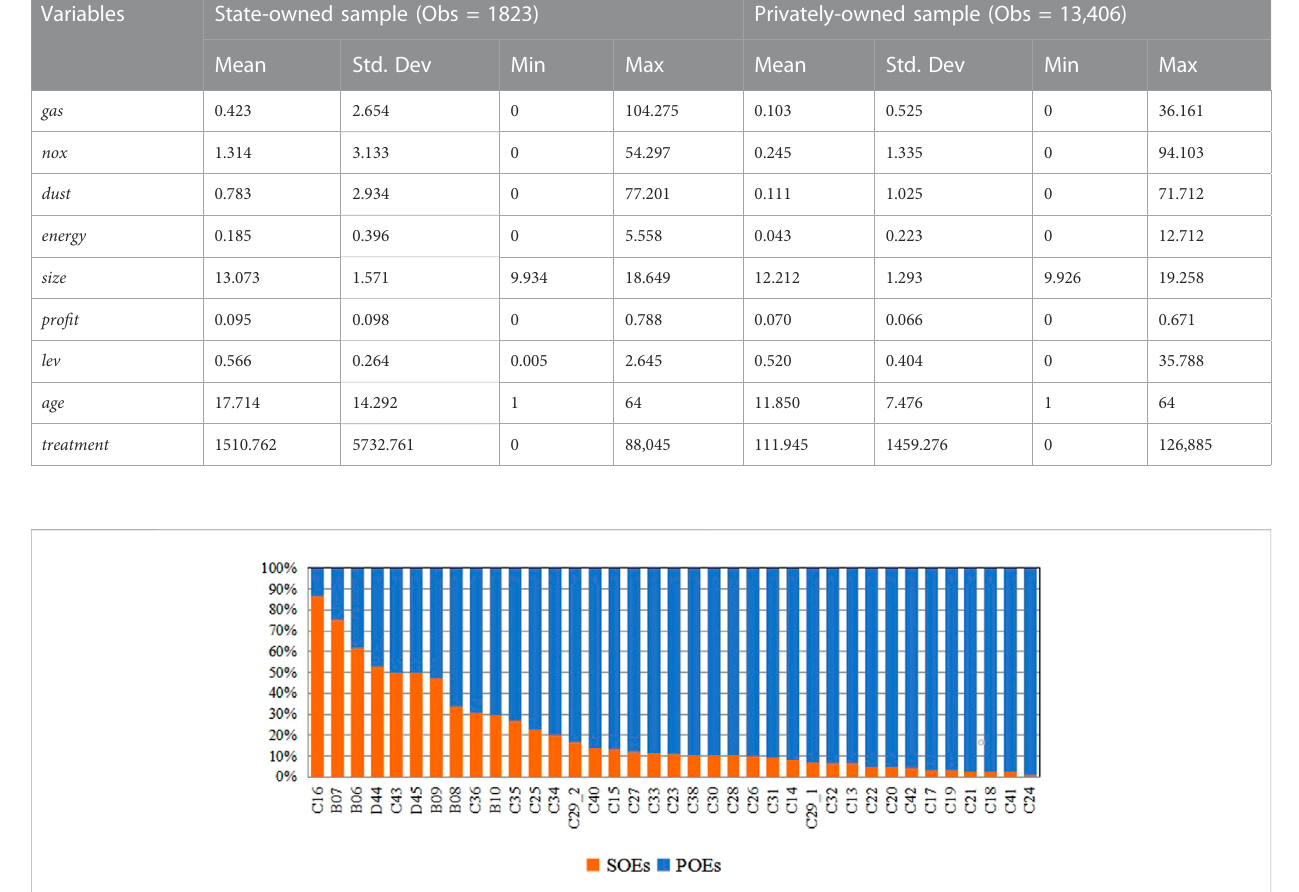
FIGURE 2 Enterprises distribution of 39 industrial sectors in China. Notes: the industry code is shown in Appendix